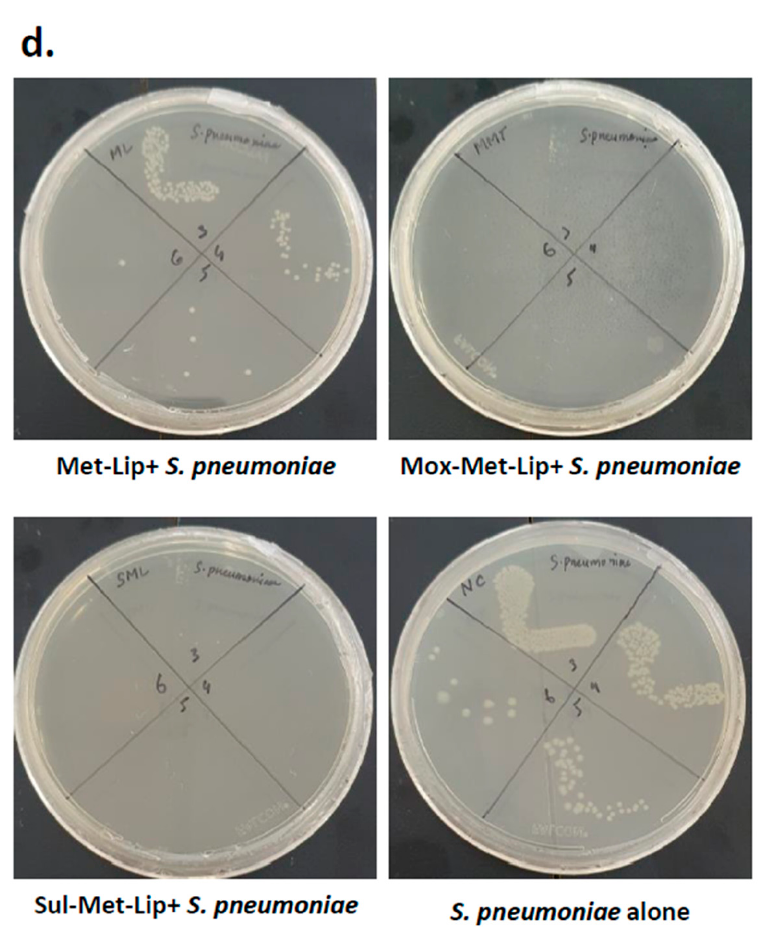
Figure 5. Drug-loaded nanocarriers presented significant antibacterial activity against Gram-positive clinical isolates. In brief, drugs and drug-loaded nanocarriers were incubated with one million bacteria at 37 ◦ C for 2 h, as defined in Materials and Methods. The results showed that drugs and drug-loaded nanocarriers revealed important bactericidal activity against the Gram-positive bacteria. ( a ) When tested against MRSA, ( b ) against B. cereus , ( c ) S. pneumoniae and ( d ) illustrative effects of S. pneumoniae. Where MeOH represents methanol, Mox represents Moxifloxacin, MML stands for Moxifloxacin-loaded metronidazole liposomes, Sulp stands for Sulfamethaxazole, SML represents Sulfamethaxazole-loaded metronidazole liposomes, Met-Lip indicates metronidazole liposomes, and Gent represents Gentamicin. The data are expressed as the mean ± standard error of three independent experimentations performed in duplicate, where (*) represents when p ≤ 0.05.